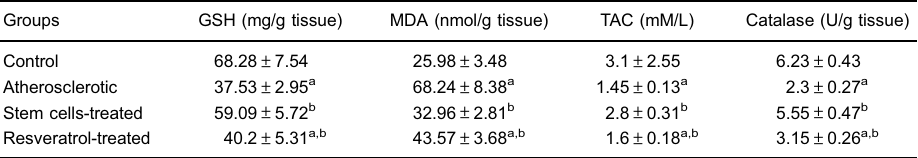
Table 3. Total antioxidant capacity (TAC), catalase, glutathione (GSH), and malondialdehyde (MDA) in rats experimentally induced with atherosclerosis and treated with stem cells or resveratrol. Groups